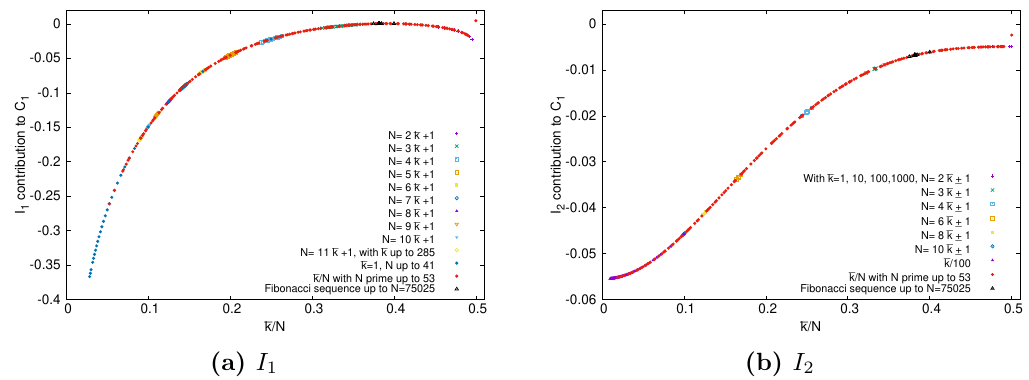
Figure 3. Dependence on ^ (cid:18) of the I 1 and I 2 contributions to C 1 at c = 0 : 30.